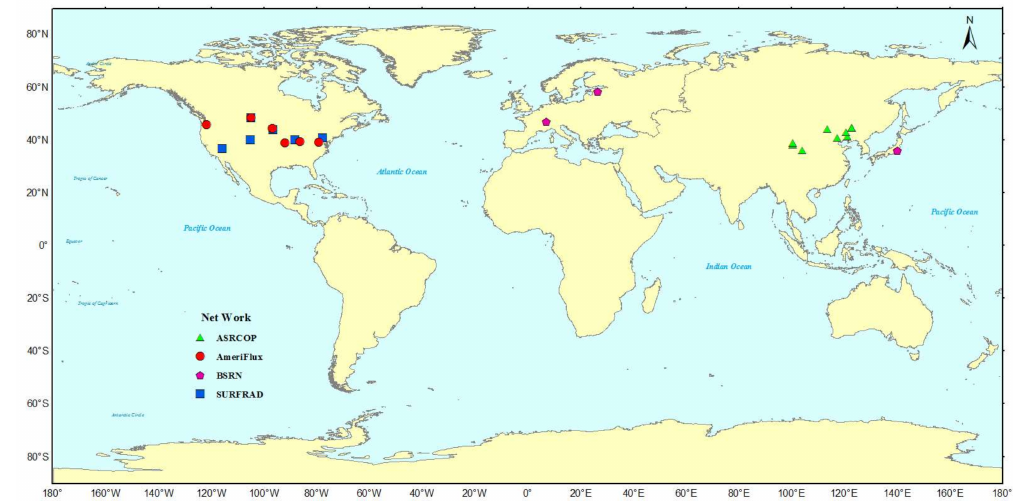
Figure 1. Spatial distribution of the 24 sites that were used in this study. Surface Radiation (SURFRAD); Baseline Surface Radiation Network (BSRN); Arid and Semi-Arid Region Collaborative Observation Project